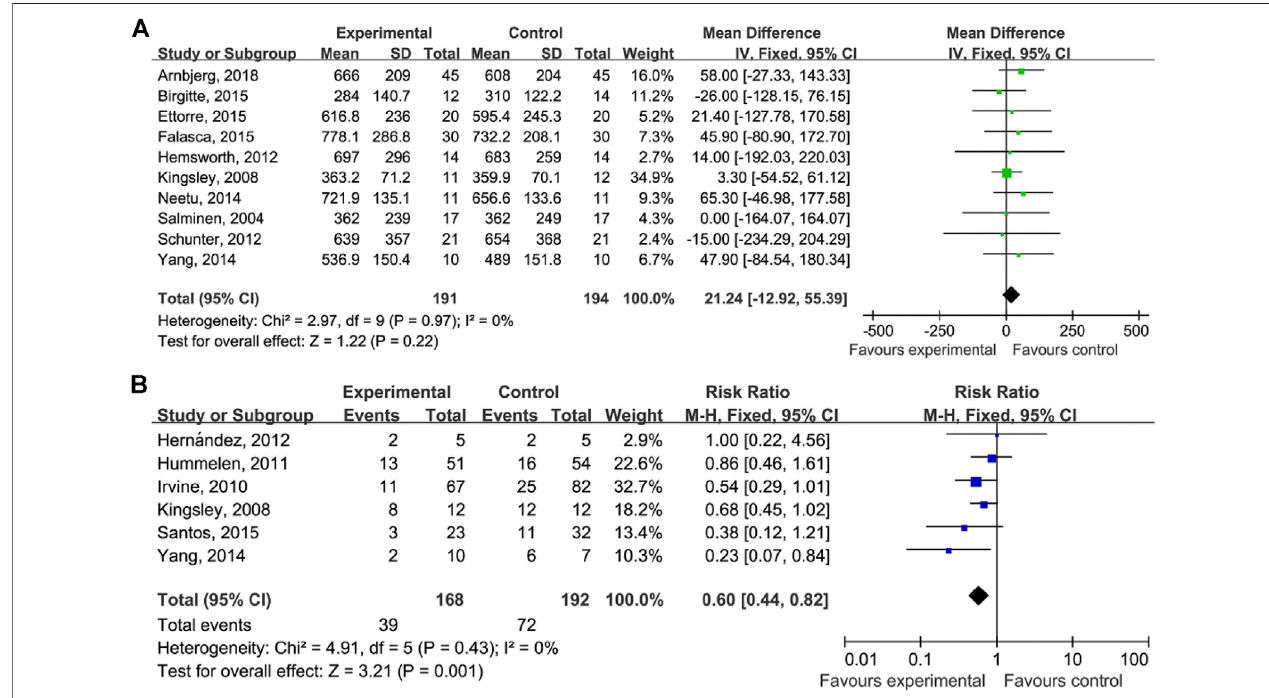
FIGURE 3 | Probiotics on CD4 count and AIDS-related diarrhea. (A) Estimates for probiotics associated with CD4 counts in the meta-analysis. (B) Estimates for probiotics associated with AIDS-related diarrhea in the meta-analysis.